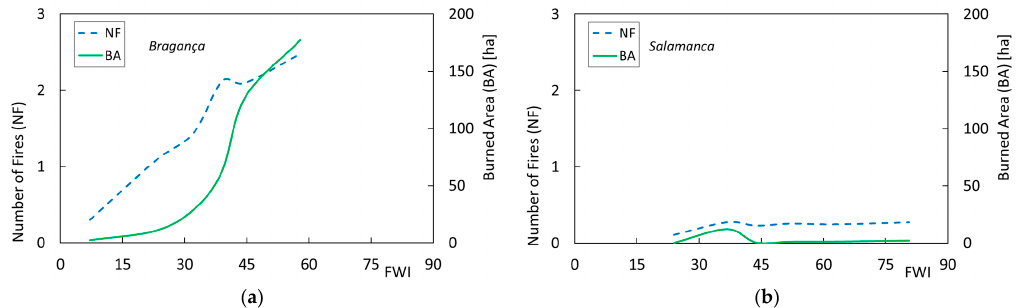
Figure A5. Average number of daily fires (NF) and burned area (BA) as a function of FWI for: ( a ) the Portuguese District of Bragança and ( b ) the Spanish Province of Salamanca.